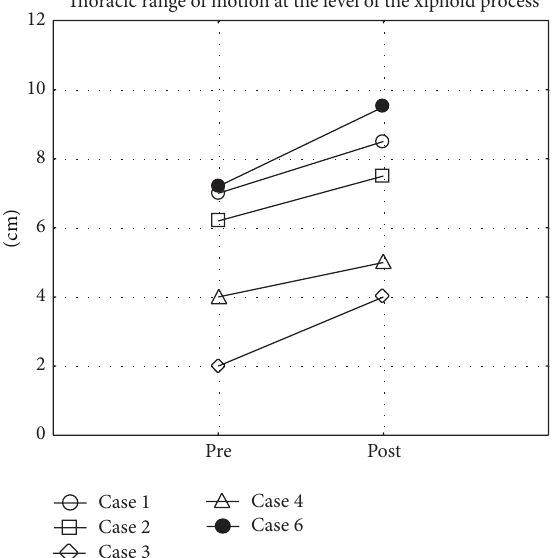
Figure 1: Difference in thoracic range of motion between maximal inhalation and exhalation at the level of the xiphoid process before (pre) and after (post) 12 weeks of Glossopharyngeal Insufflation (missing data on 1 subject).